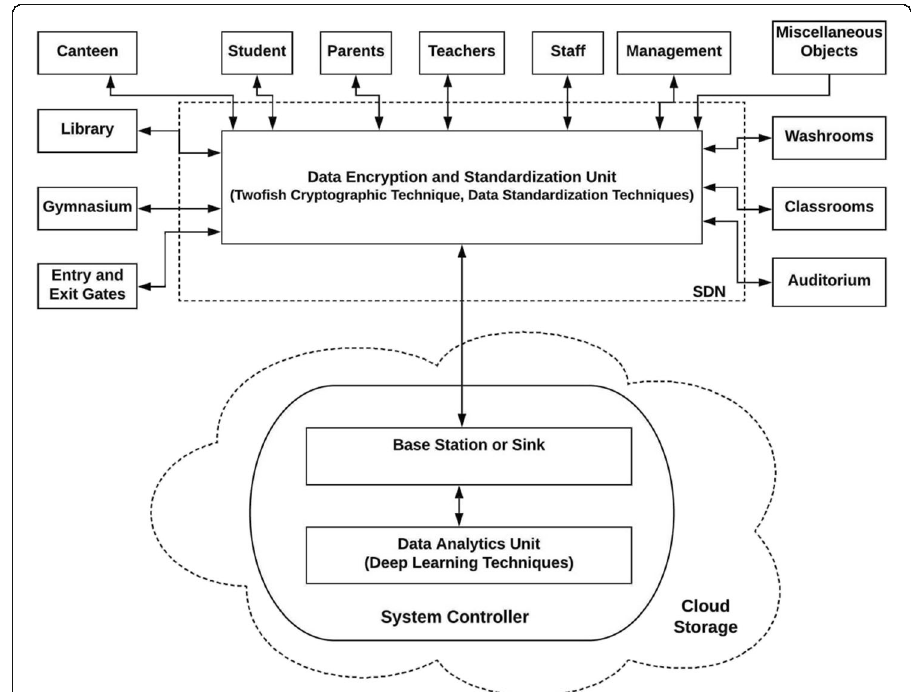
Fig. 3 Architecture of IoE based Educational Model. The architecture consists of various components of the proposed IoE based Education Model. The system controller is the brain of the system which is responsible for coordinating all the activities within the